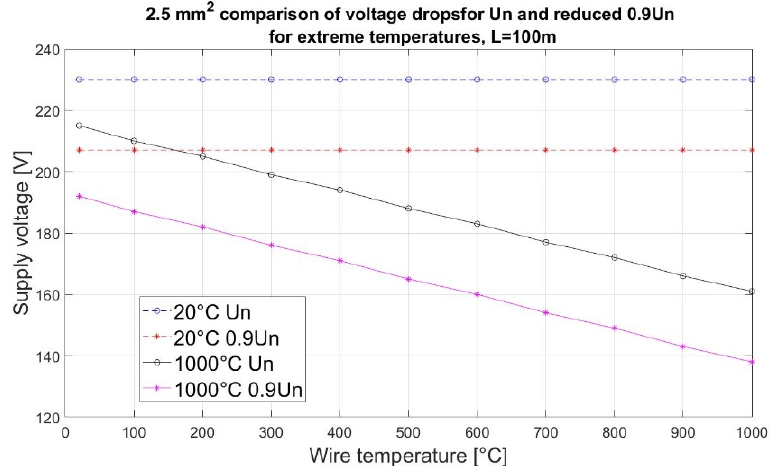
Figure 13. Simulated voltage drop depending on the cable temperature.